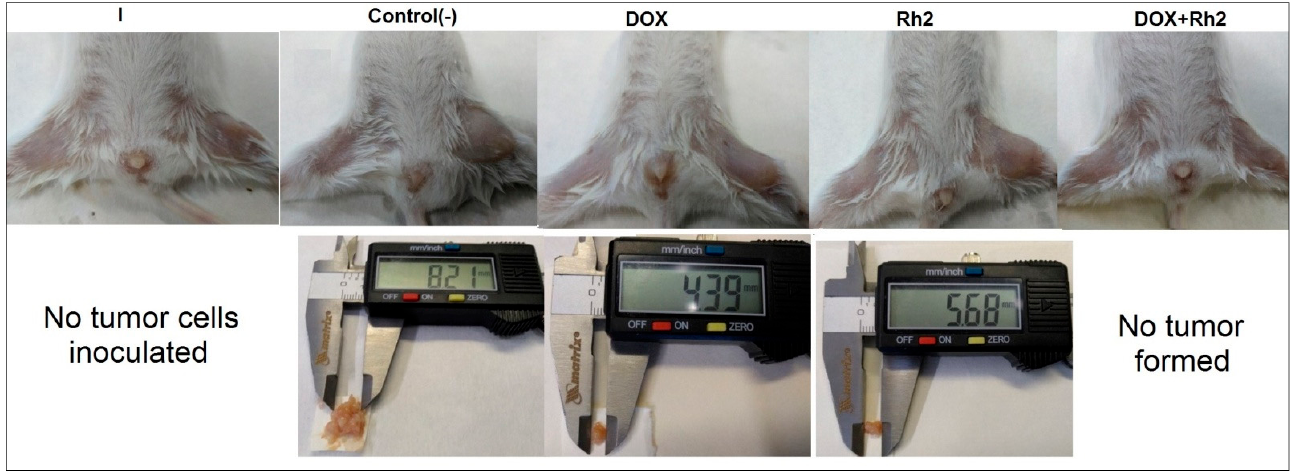
Figure 3. Tumor formation by day 17 (Variant A, early treatment protocol) and its size in non-treated group (N), DOX group, and Rh2 group. No tumor in the intact animals (I), or in DOX + Rh2-treated animals.